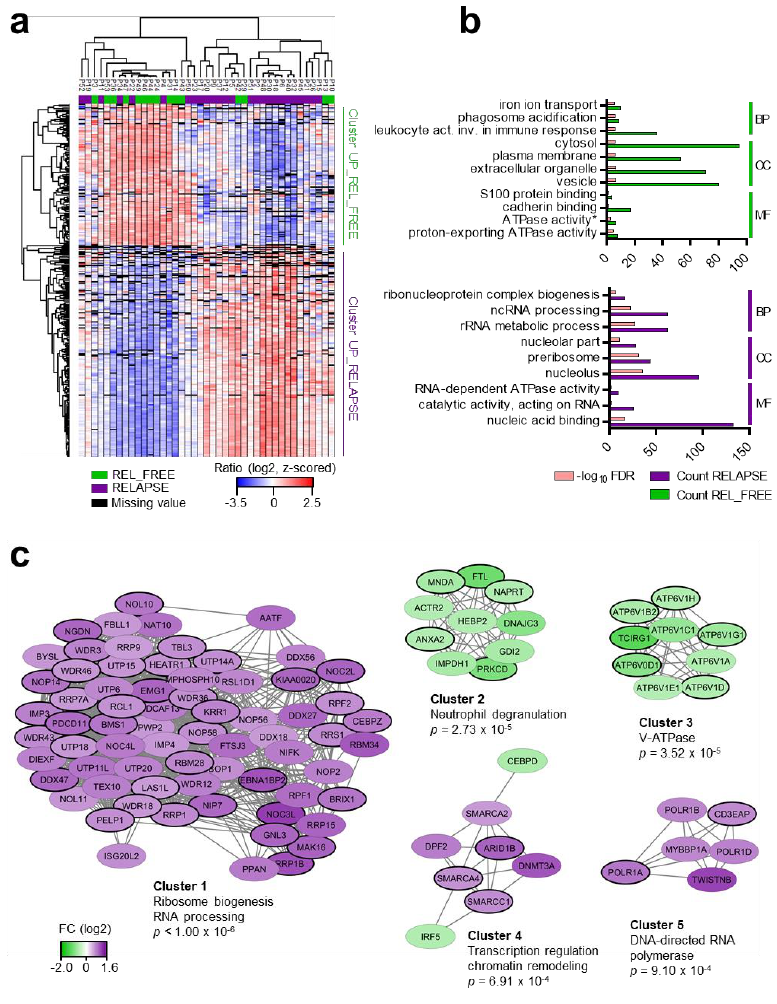
Figure 2. The global AML cell proteome shows increased abundance of rRNA processing proteins and decreased abundance of V-ATPase subunits for patients who relapse. ( a ) Hierarchical clustering of the patients (P1-P53), based on protein expression (SILAC log 2 ratio) of the 351 proteins with significantly different regulation in AML cells from REL_FREE (green) and RELAPSE (purple) patients. Two vertical main clusters were observed, one dominated by proteins with higher abundance in mostly REL_FREE patients (Cluster UP_REL_FREE) and the other by proteins with higher abundance in RELAPSE patients (Cluster UP_RELAPSE). ( b ) Gene ontology (GO) analyses of the two protein clusters identified in Figure 2a were performed, to reveal enriched biological processes (BP; see the right side of the figure), cellular compartments (CC) and molecular functions (MF) in the two protein clusters. The upper part of the figure corresponds to the upper REL_FREE cluster identified in Figure 2a, whereas the lower part of the figure corresponds to the lower RELAPSE cluster. The various enriched GO terms are listed in the left part of the figure. The number of proteins associated to a specific GO term (count) and the corresponding –log 10 false discovery rate (FDR) of these top significant GO terms are shown on the x-axis. *The complete name of the GO term referred to as ATPase activity in the figure is “ATPase activity, coupled to transmembrane movement of ions, rotational mechanism”. ( c ) Protein–protein interactions (PPI) networks of the 351 proteins from the STRING database, visualized and analyzed with Cytoscape and ClusterONE, respectively. The five clusters with highest significance of cohesiveness are shown with p values of a one-sided Mann–Whitney U test. The protein nodes are colored according to their RELAPSE / REL_FREE log 2 fold change (FC), i.e., purple indicates increased abundance in the RELAPSE group and green increased abundance in the REL_FREE group. Protein nodes with black border represent significantly regulated proteins found in both the SILAC and label-free